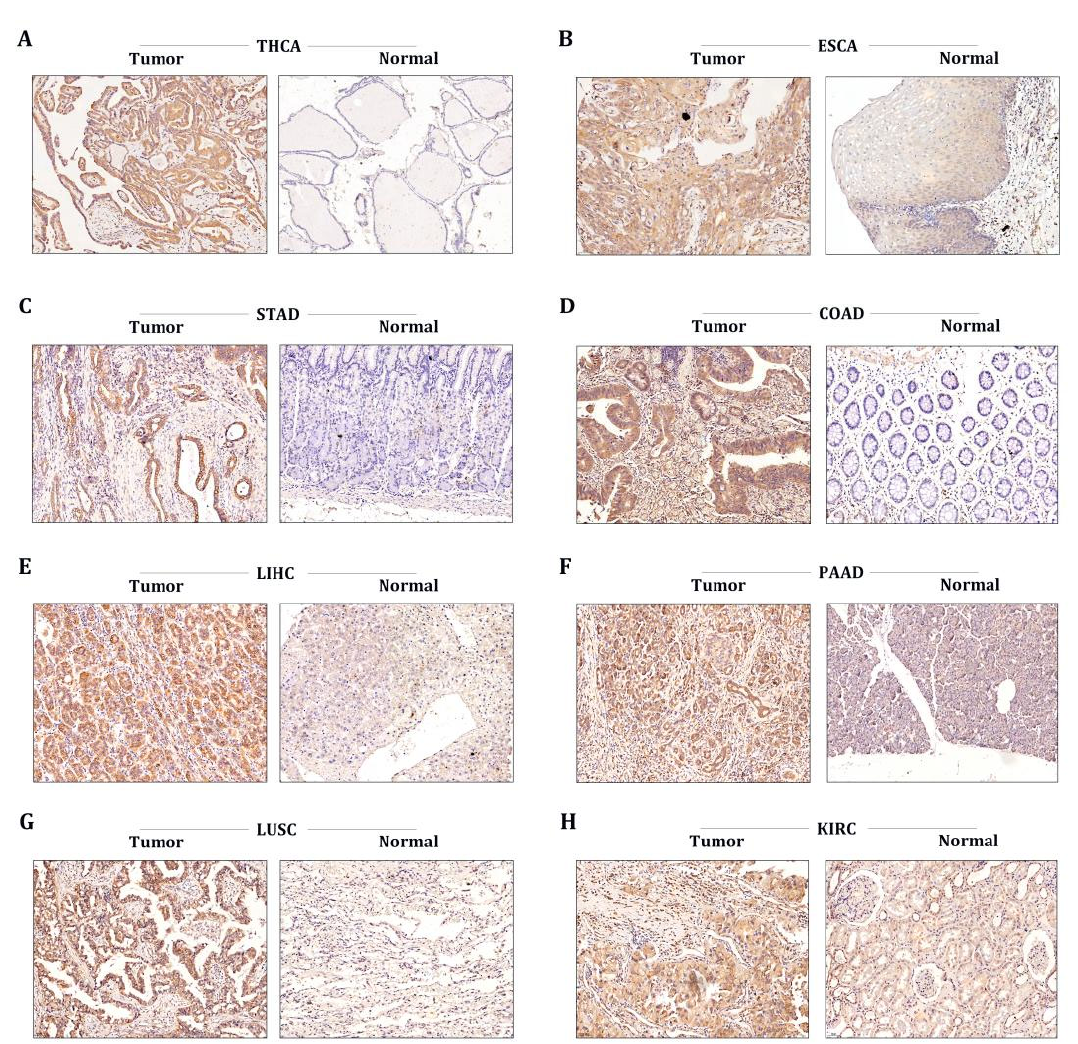
Figure 6. The STX6 level was regulated in multiple cancer clinical specimens. Immunohistochemical analysis showed that the STX6 staining score in tumor tissues was higher than that in normal tissues in all cancer types included in the study ( A – H ) (specimens were obtained from author’s institution).